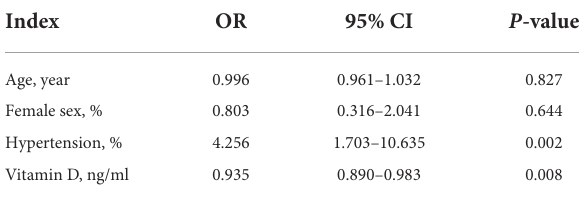
TABLE 2 Multivariate logistic regression analysis between patients with aneurysmal SAH and non-aneurysmal